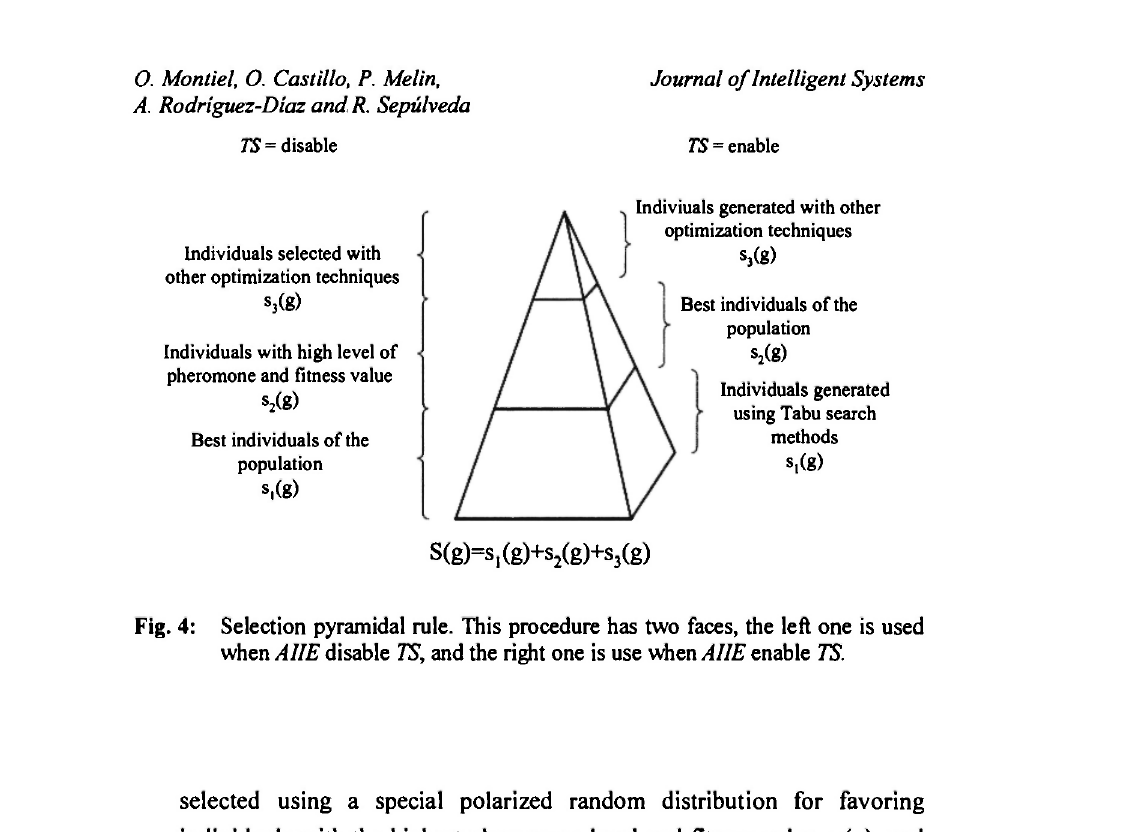
selected using a special polarized random distribution for favoring individuals with the highest pheromone level and fitness value s 2 (g), and the best individuals provided by other techniques s 3 (g). At first instance, we follow the pyramidal rule shown in Fig. 4 for representing